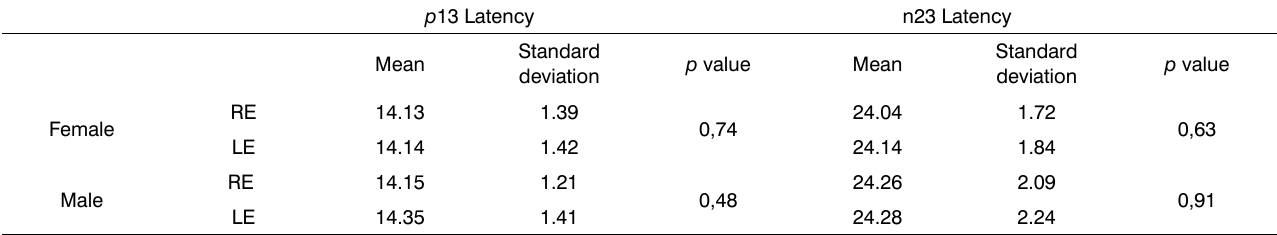
Table 1. Comparison of P13 and N23 latencies (ms) in the right and left ears, in both sexes.